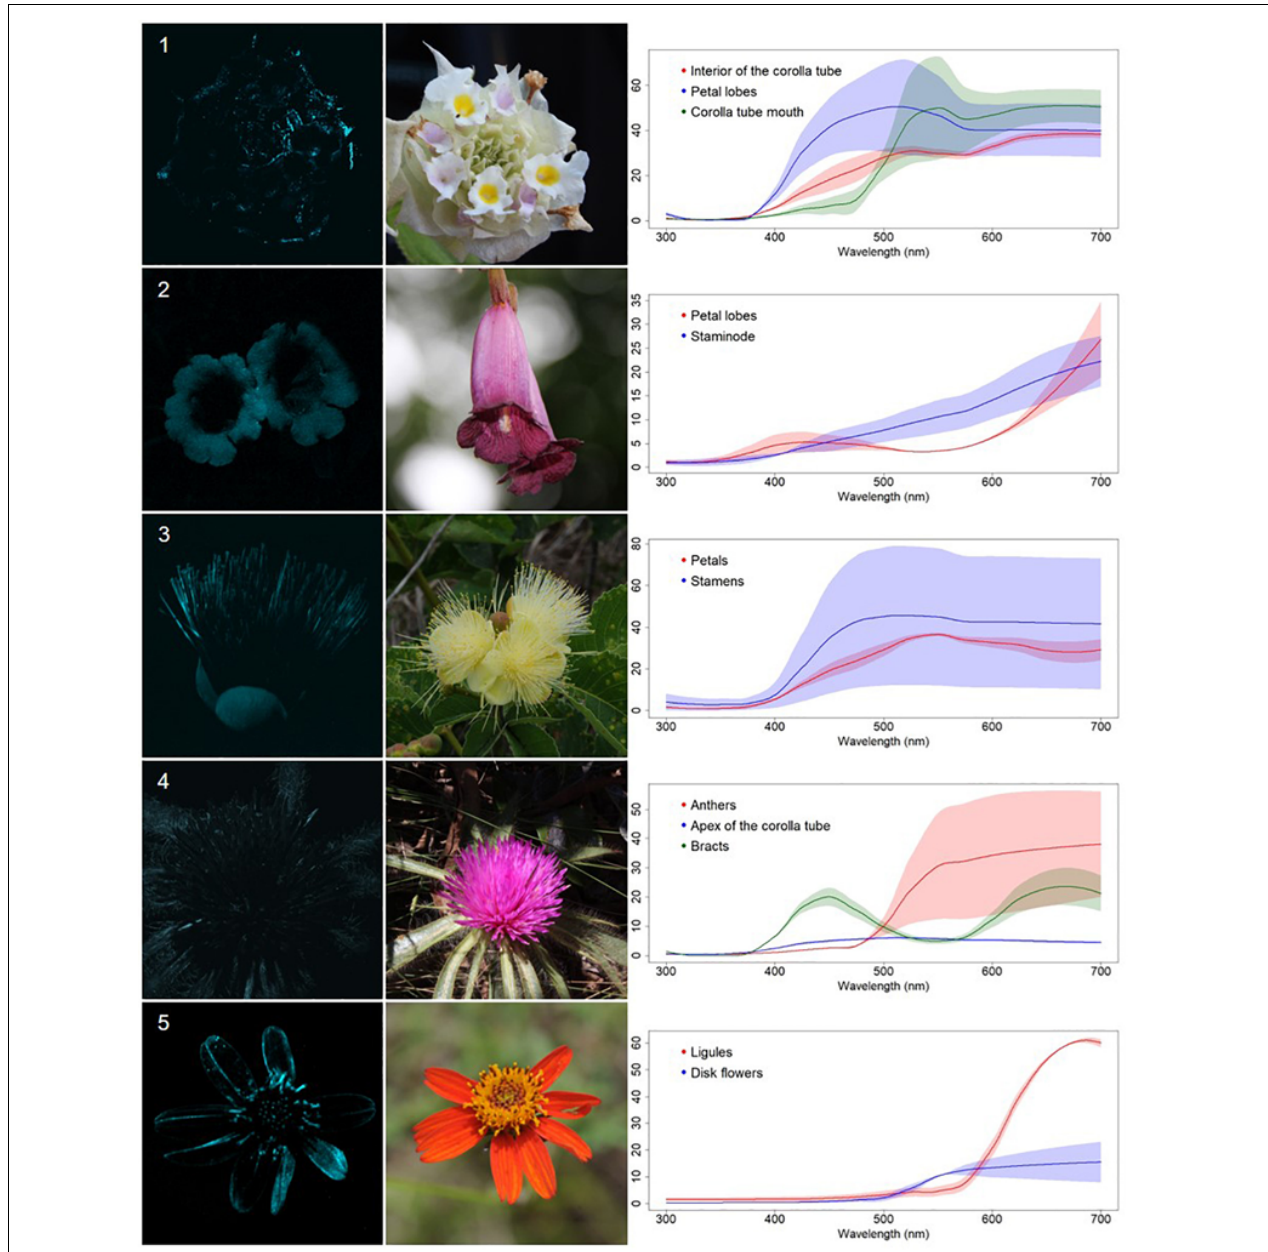
FIGURE 2 | UV-absorbing non-patterned flowers (A) from a Neotropical savanna community. Each row comprises information of one species. First column: UV-photography. Second column: flower as seen by the human eye (conventional photography). Third column: reflectance curves of different portions of the flowers. Row 1. Lippia lupulina Cham. (Verbenaceae). Row 2. Jacaranda rufa Silva Manso (Bignoniaceae). Row 3. Caryocar brasiliense A.St.-Hil. (Caryocaraceae). Row 4. Gomphrena macrocephala A.St.-Hil. (Amaranthaceae). Row 5. Bidens gardnerii Baker (Compositae).